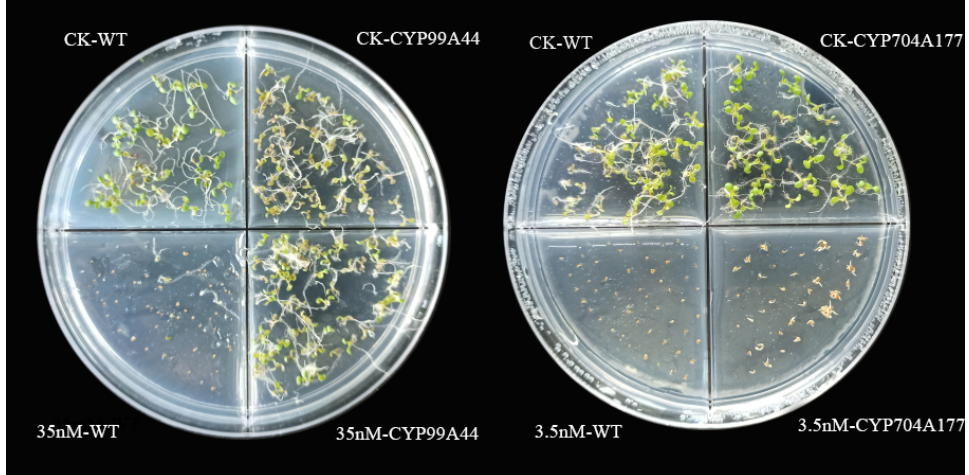
Figure 4. Susceptibility of in Arabidopsis transformed with CYP99A44 or CYP704A177 to mesosulfuron-methyl. Seedlings of the transgenic Arabidopsis grown on media containing no herbicide (CK), at 3.5 nM ( right ) and 35 nM ( left ) mesosulfuron-methyl.